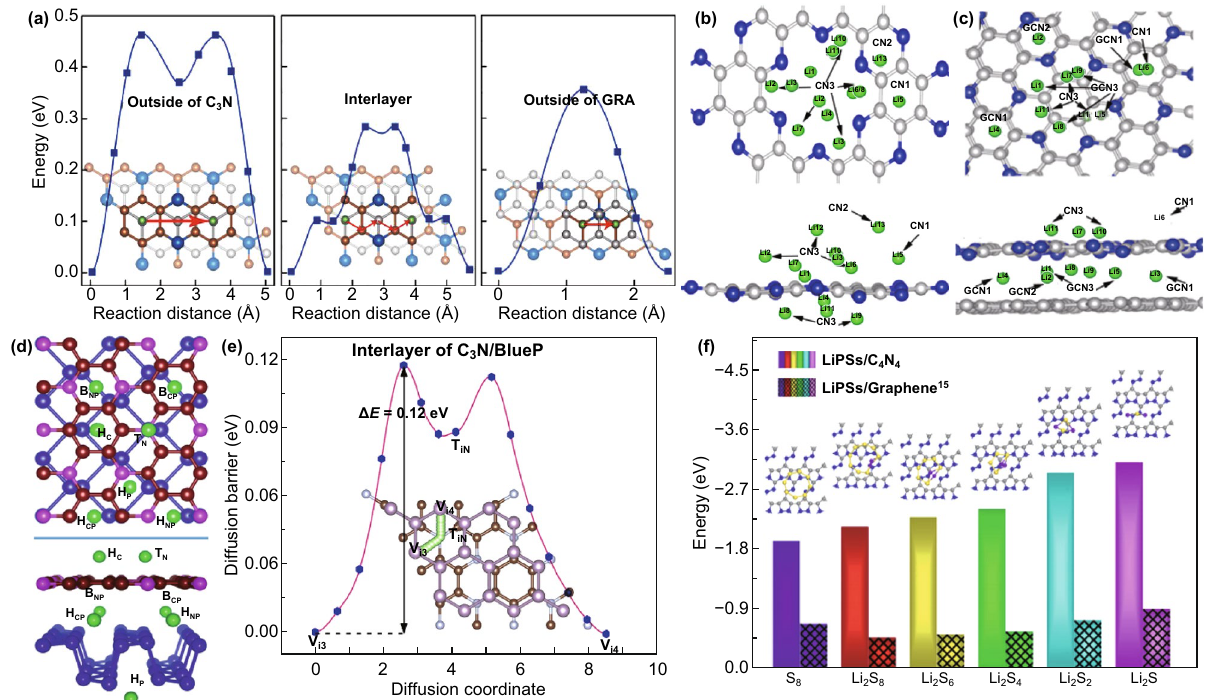
Fig. 9 a Energy profiles for Li atom diffusion on C 3 N/GRA, along with the corresponding pathways denoted as red arrows. Carbon atoms from graphene—gray balls, carbon atoms from C 3 N—orange balls, nitrogen atoms—blue and lithium atoms—green. Reproduced with permission from Ref. [37]. b Top and side views of Li 13 –C 2 N structure; c top and side views of the Li 11 –C 2 N/graphene bilayer. Different adsorption sites are indicated as CN1, CN2, CN3, GCN1, GCN2, and GCN3 for both structures. Reproduced with permission from Ref. [38]. d Top and side views of the Li adsorption site on the C 3 N/P heterostructure (Li/C 3 N/P, C 3 N/Li/P, and C 3 N/P/Li). HC and TN sites are on the outer surface of C 3 N, and HP site is on the outer surface of phosphorene, HCP, HNP, BCP, and BNP sites are in the interlayer of the C 3 N/P heterostructure. Reproduced with permission from Ref. [64]. e Lithium migration pathway and corresponding energy profile through Path II of the interlayer of C 3 N/Blue P heterostructure. Reproduced with permission from Ref. [65]. f Adsorption energy for S 8 cluster and LiPSs on C 4 N 4 monolayer (bars without patterns) and graphene (bars with patterns), respectively. The insets on the pillars show S 8 or Li 2 Sn/C 4 N 4 structures generated by the principle of minimum energy. Reproduced with permission from Ref. [56]. Copyright permissions from Elsevier, American Chemical Society and Royal Society of Chemistry. (Color figure